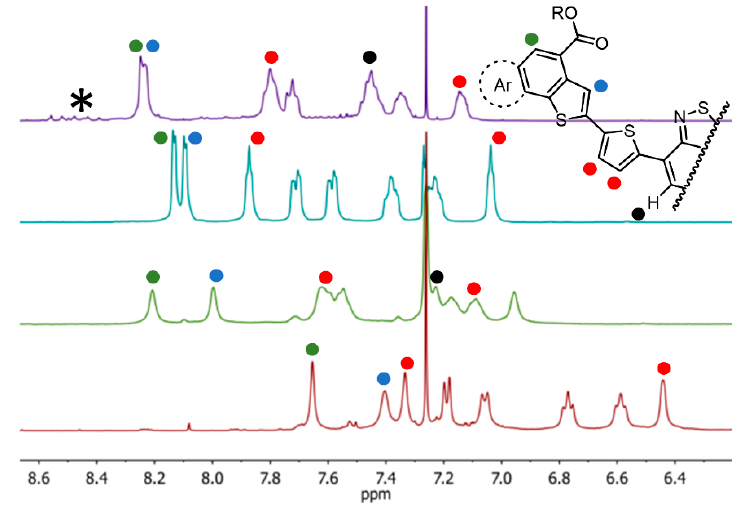
Figure 2. Stacked 1 H NMR (200 MHz, CDCl 3 ) of compounds (from top to bottom): 7 (pink), 8 (blue), 9 (green) and 10 (red). The asterisk denotes small impurities present in the sample of compound 7 .